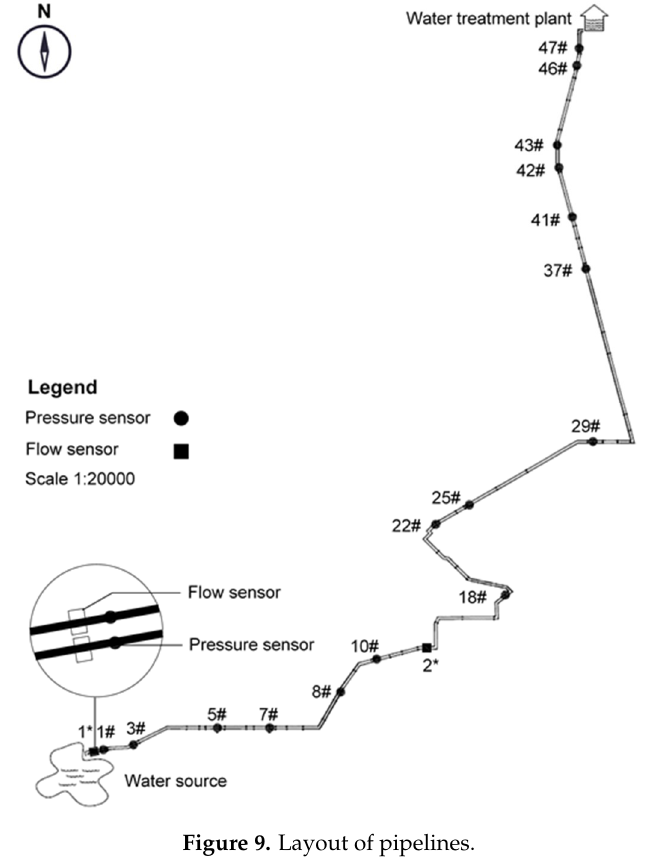
Figure 9. Layout of pipelines.